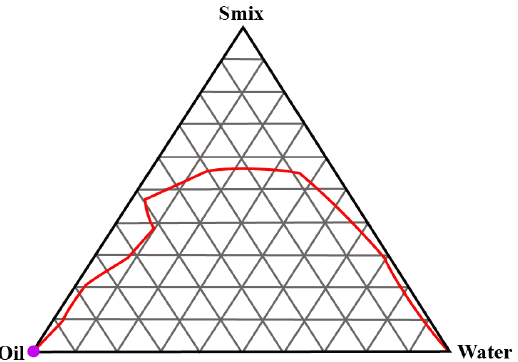
Figure 1. Pseudoternary phase diagram between IPP, water and S mix (1:1). The red line shows the boundary between the monophasic and biphasic region. The area above redline represents the monophasic region.